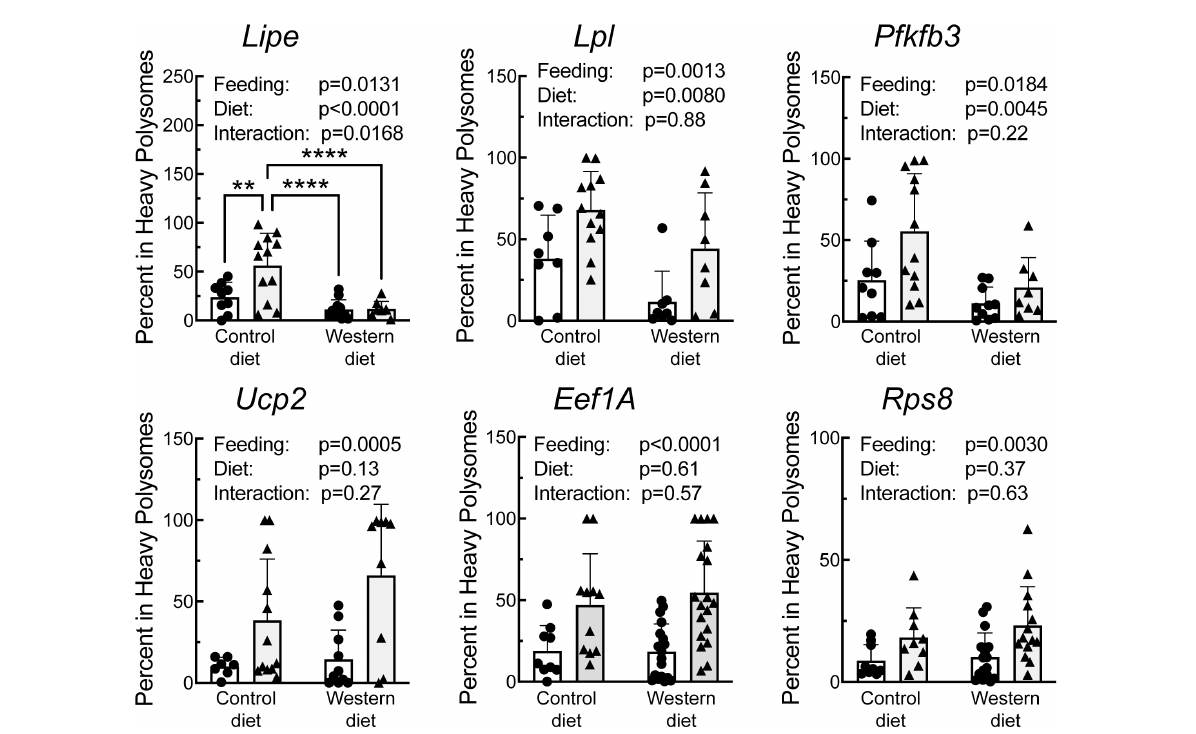
FIGURE 6 qRT-PCR analysis of the proportion of mRNA in the heavy fraction from sucrose density gradient fraction of livers from rats fed a control diet or a Western diet for 2 weeks. N=8-12 rats/group. **p<0.005,